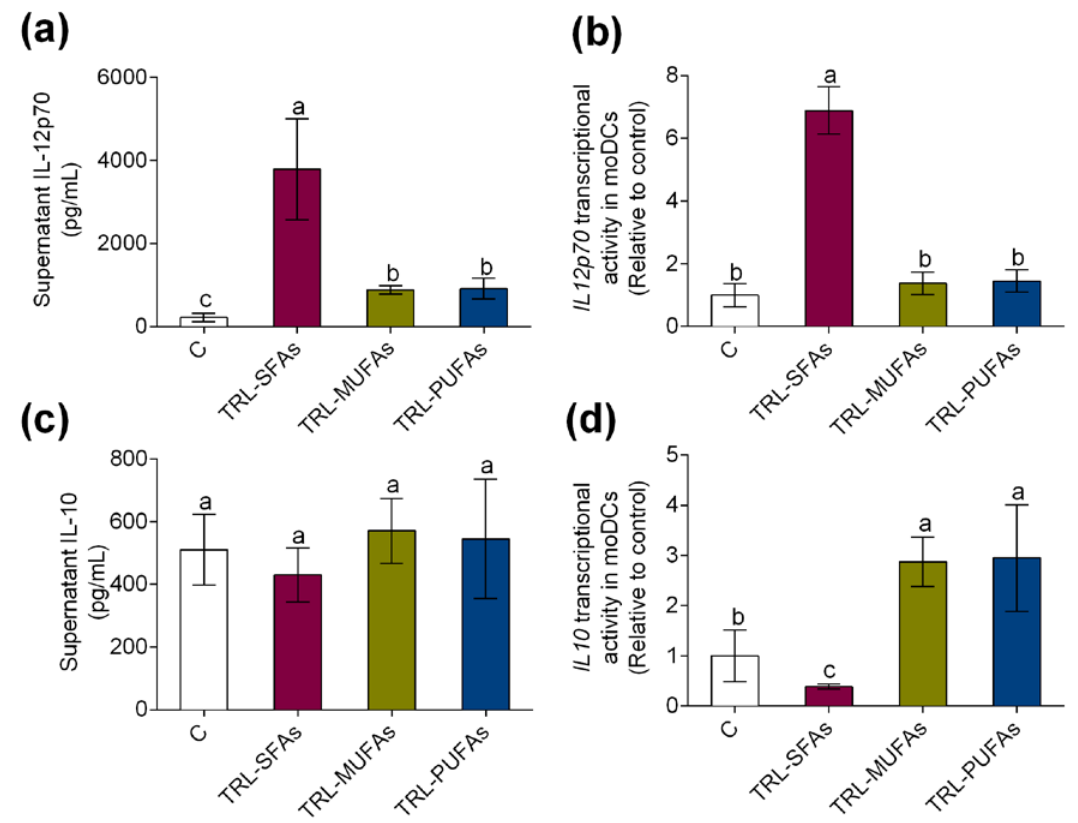
Figure 4. In vitro expression and secretion of proinflammatory and tolerogenic cytokines in moDCs after stimulation with TRL-SFAs, TRL-MUFAs, and TRL-PUFAs at 100 µg of TGs/mL for 6 days and in presence of GM-CSF and IL-4. ( a ) IL-12p70 secretion and ( b ) mRNA expression. ( c ) IL-10 secretion and ( d ) mRNA expression. Values are presented as means ± SD ( n = 6) and those marked with different letters are significantly different ( p < 0.05).